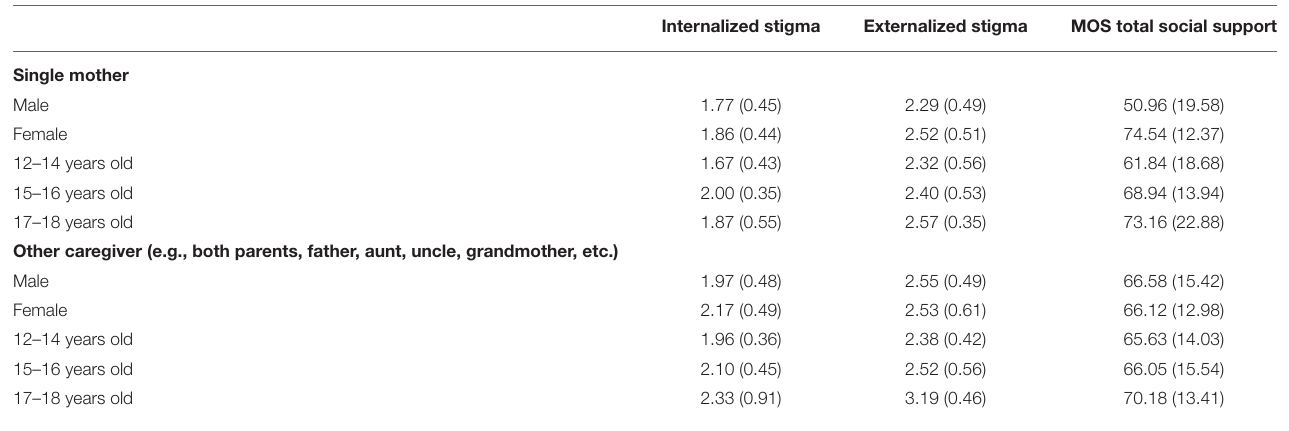
TABLE 2 | Mean scores for outcomes by caregiver type—single